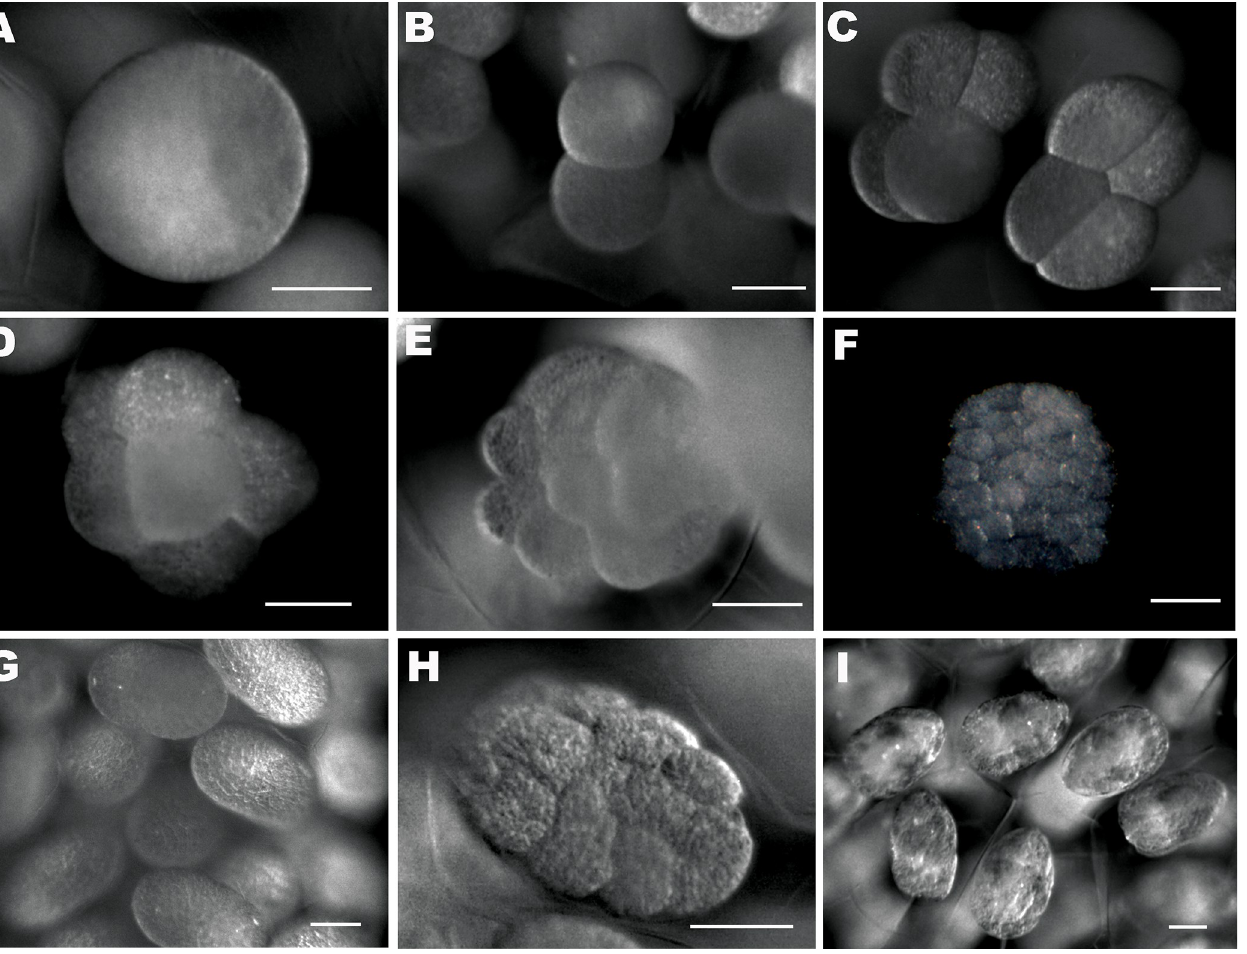
Fig 1. The embryonic stages of Ive ptychoderae. (A) One-cell stage; (B) 2-cell stage; (C) 4-cell stage; (D) 8-cell stage; (E) 16-cell stage; (F) Blastula stage; (G) Gastrula stage; (H) Early limb bud stage; (I) Late limb bud stage. Scale bars: A = 0.5 mm; B–I = 0.05 mm. Fig 4. Body (Fig 4A) oval or pear-shaped, full of yolky granules (see Fig 3B), longer than wide, Average length 163 (161–166) μ m and greatest width 105 (103–107) μ m based on 10 speci- mens. Three pairs of swimming appendages: antennule, antenna, and mandible. Labrum (Fig 4A) curved prominence without ornamentation. Caudal armature (Fig 4A) represented by 1 pair of fine setae. Antennule (Fig 4A and 4B) uniramous, 1-segmented, armed with 1 proximo- ventral, 1 midventral and 2 unequal terminal setae. Antenna (Fig 4A and 4C) biramous, with exodopod slightly longer than endopod; coxa without masticatory process, separate from short basis; exopod 4-segmented, first segment elongated and fused with basis, each segment armed with 1 seta; endopod 2-segmented, first segment unarmed, indistinctly separate from basis, second segment armed with 2 plumose setae. Mandible (Fig 4A and 4D) biramous, coxa sepa- rate from basis, both coxa and basis unarmed. Exopod 5-segmented, each armed with 1 plu- mose seta except for first segment; first segment elongated, fused with basis. Endopod 1-segmented, armed with 1 proximoventral, 1 midventral, and 2 equal terminal setae. Nauplius II